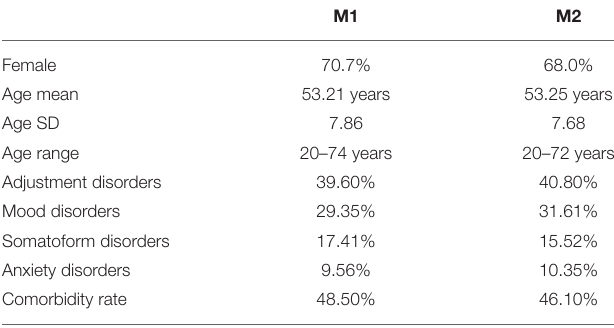
TABLE 2 | Descriptive sample characteristics Study